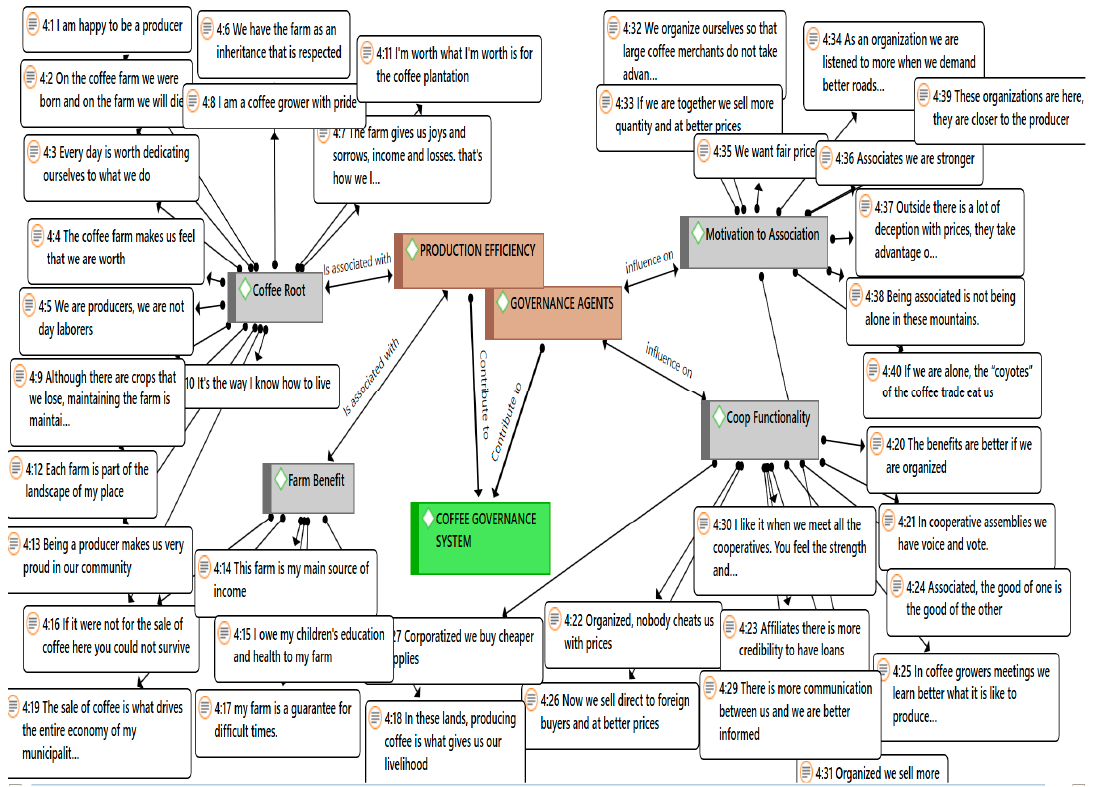
Figure 4. Elements of governance analyzed, translated into English by the author from interviews processed in ATLAS.ti.